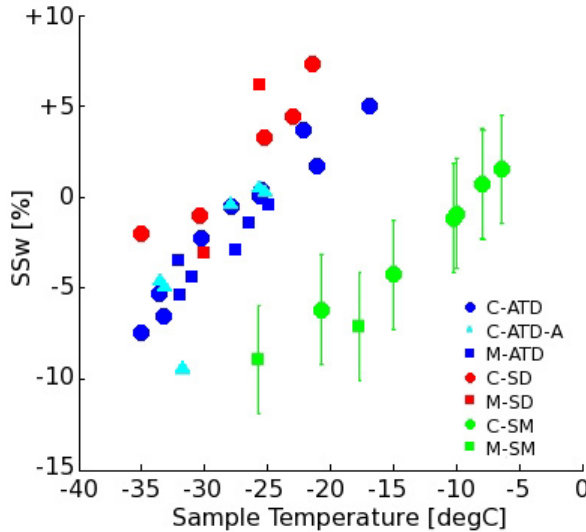
Fig. 11. Results from all MINC (squares) and CSU (circles) SS- scans for Arizona Test Dust (blue), Saharan Test Dust (red) and Snomax® (green). Points represent the conditions at which the 1 in 1000 particles were activated. CSU adjusted data points are also shown (cyan triangles). SS water error bars are shown for Snomax® data (based on Richardson et al., 2010). The results shown in Figs. 9 and 10 are represented on this